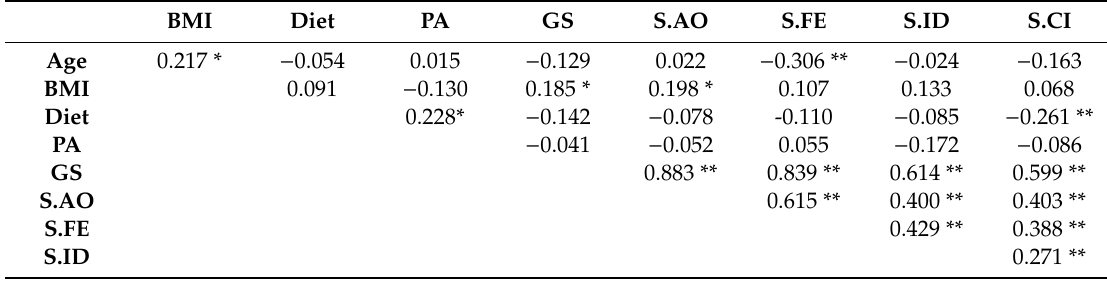
Table 5. Bivariate correlations between the